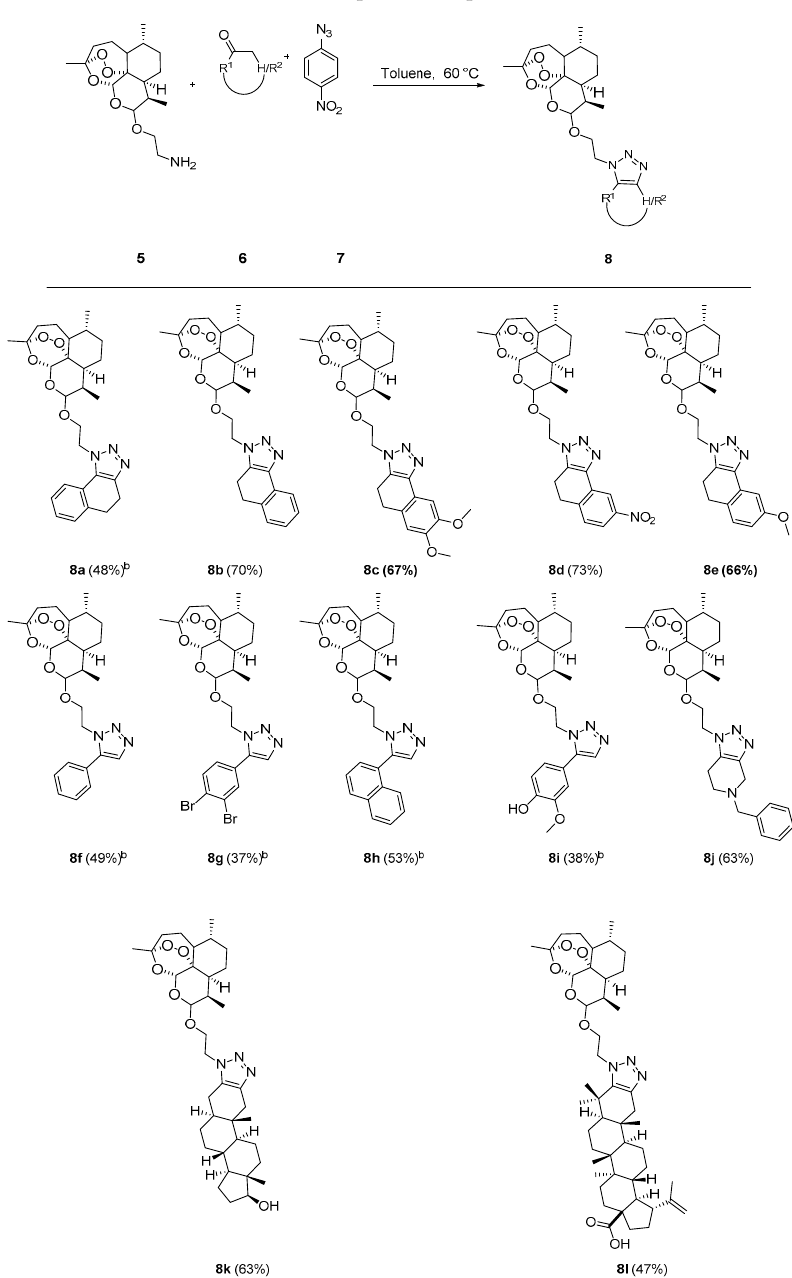
Table 1. Substrate scope with respect to ketones a .